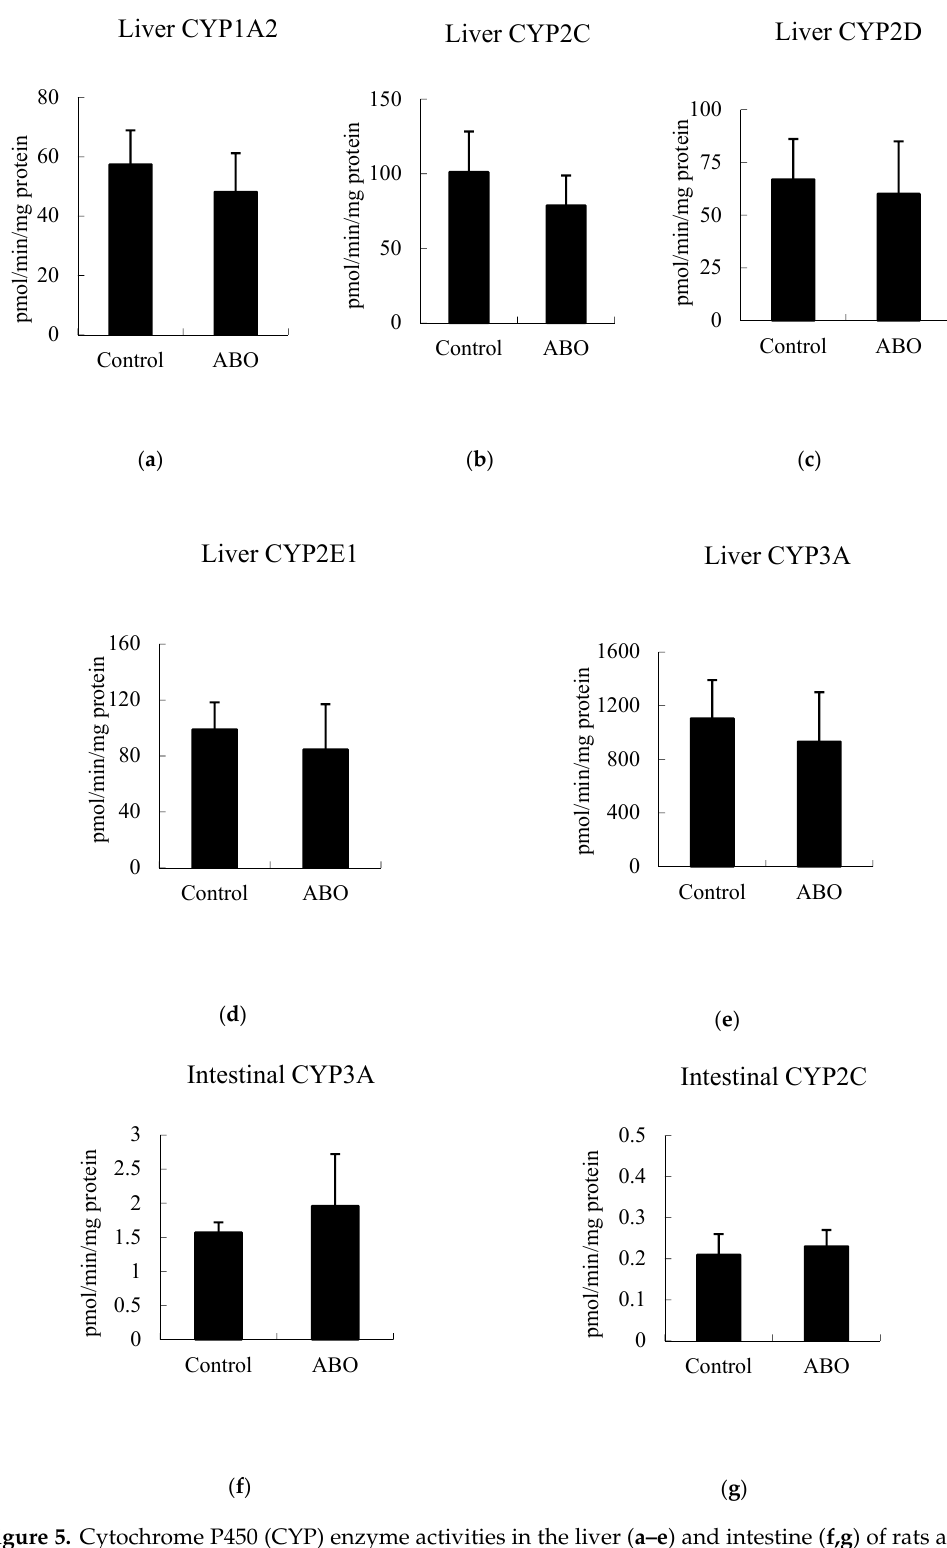
Figure 5. Cytochrome P450 (CYP) enzyme activities in the liver ( a–e ) and intestine ( f,g ) of rats after feeding with ABO-containing diet for 7 days.